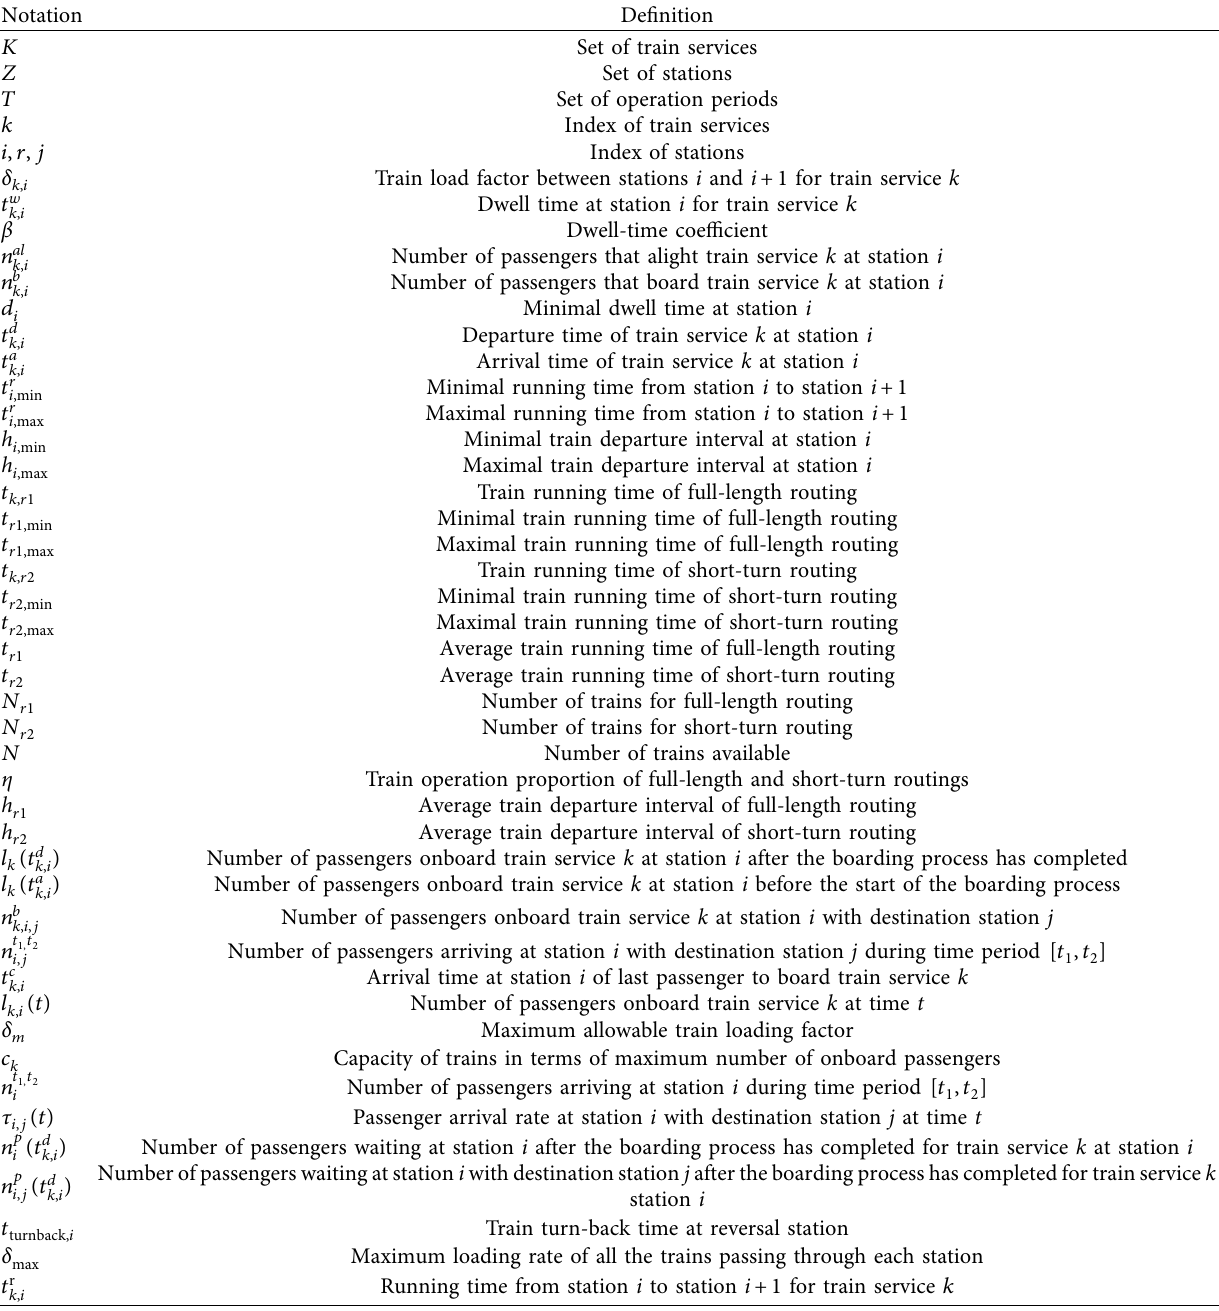
Table 1: Parameters and intermediate